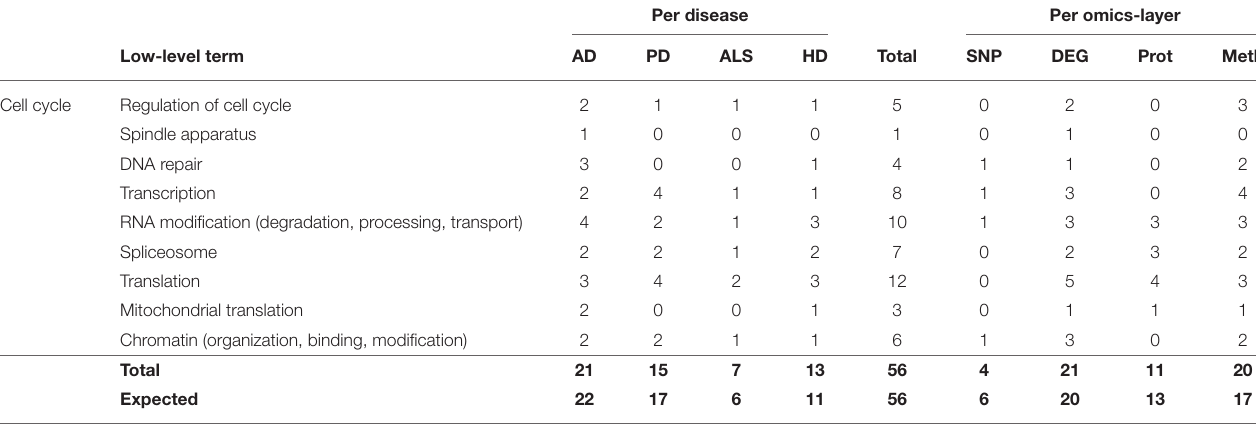
The column for the total number of low-level terms found refers to both the sum across all four NDDs and the sum across all four omics-layers. This table is intended to provide summary information about the accumulated data—the number of individual low-level terms per omics-layer for each disease can be found in the Supplementary Table 3 . SNP, genomic level; DEG, transcriptomic level; Prot, proteomic level; Meth, methylomic level.